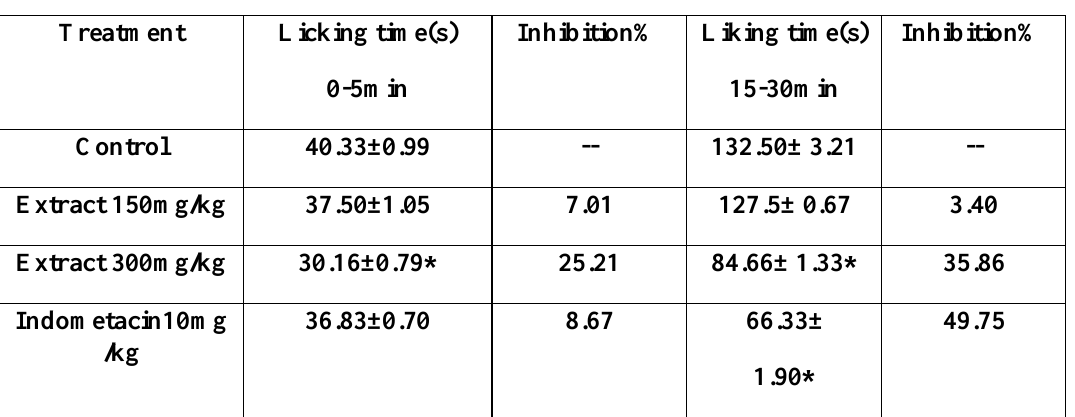
Table3: Shows the effect of Mentha pipterita extract and indometacin on formalin- induced licking in mouse.